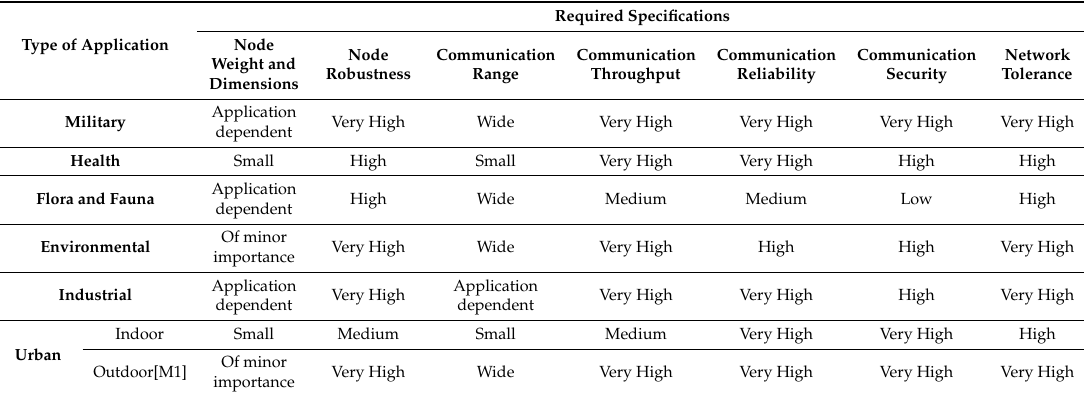
Table 1. Required specifications of Wireless Sensor Networks (WSNs) per type of